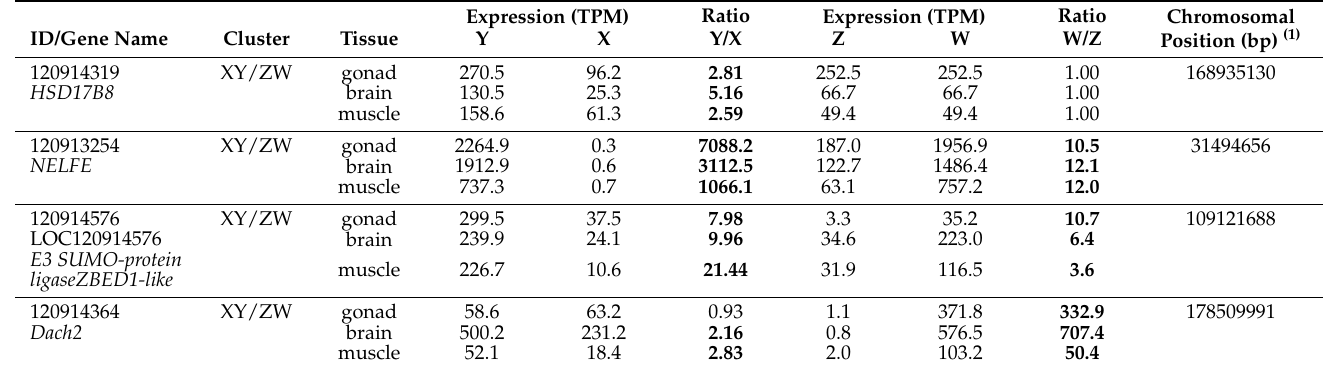
Table 2. Four sex-linked genes showing high expression ratios of Y/X and/or W/Z. Expression (TPM) Ratio Expression (TPM)